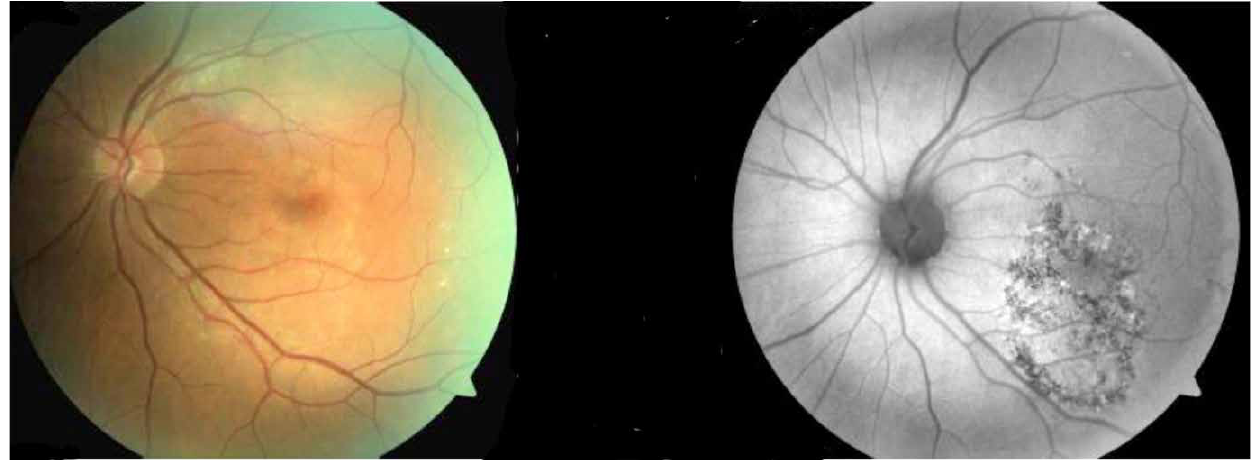
Figure 3: Central serous chorioretinopathy (CSR). An increase in autofluorescence is normally seen in acute CSR probably indicating an increased metabolic activity of the retinal pigment epithelium. The above lesion is probably long standing judging from the focal and decreased autofluorescence which would indicate reduced metabolic activity in the retinal pigment epithelium due to photoreceptor loss. (Photograph courtesy of Dr Peter